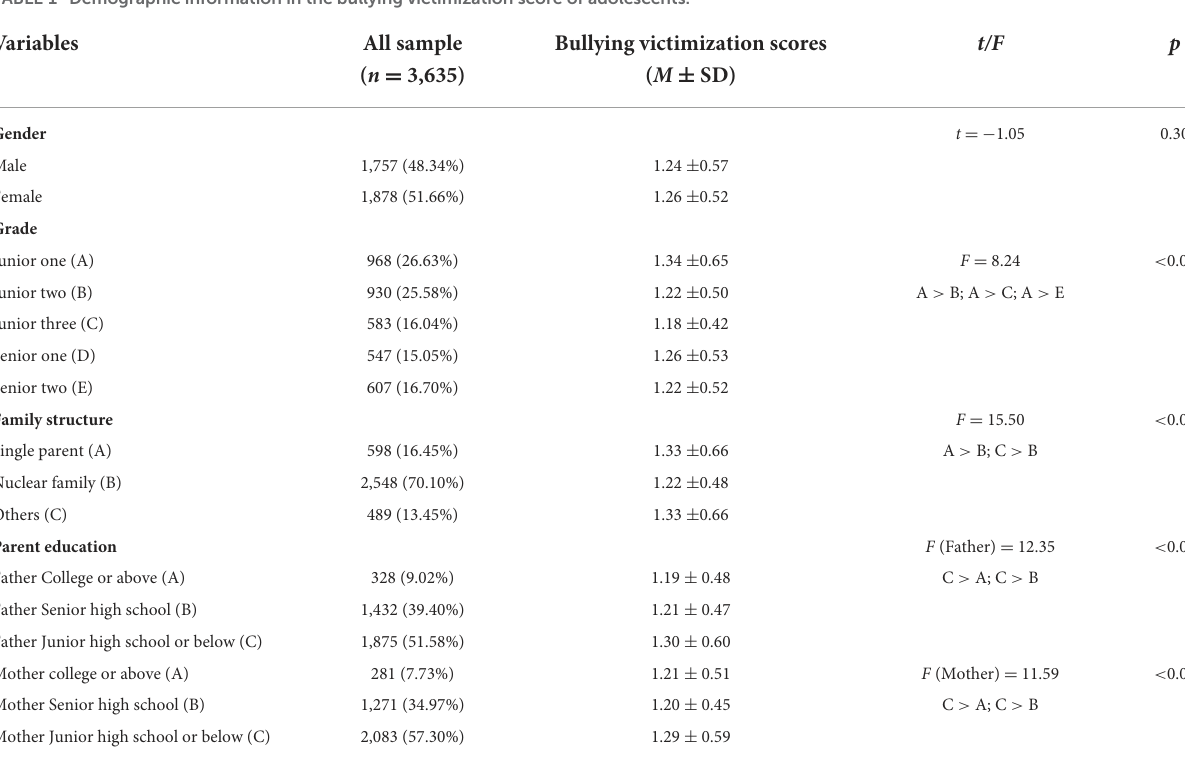
TABLE 1 Demographic information in the bullying victimization score of